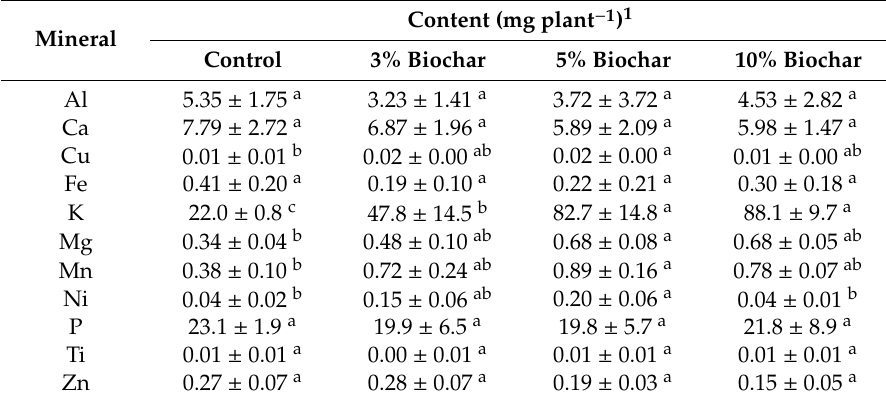
Figure 6. Soil pH and concentration of major inorganic nutrients in the jatropha biochar-amended soils at the time of harvest. The soil pH ( A ) and ammonium ion ( B ) and nitrate ion ( C ) contents are shown. Values are means ± standard deviations ( n = 3 pots). Bars with different letters are significantly different (Holm’s test, p < 0.05). Table 3. Amount of minerals in the aerial parts of the Swiss chard plants.